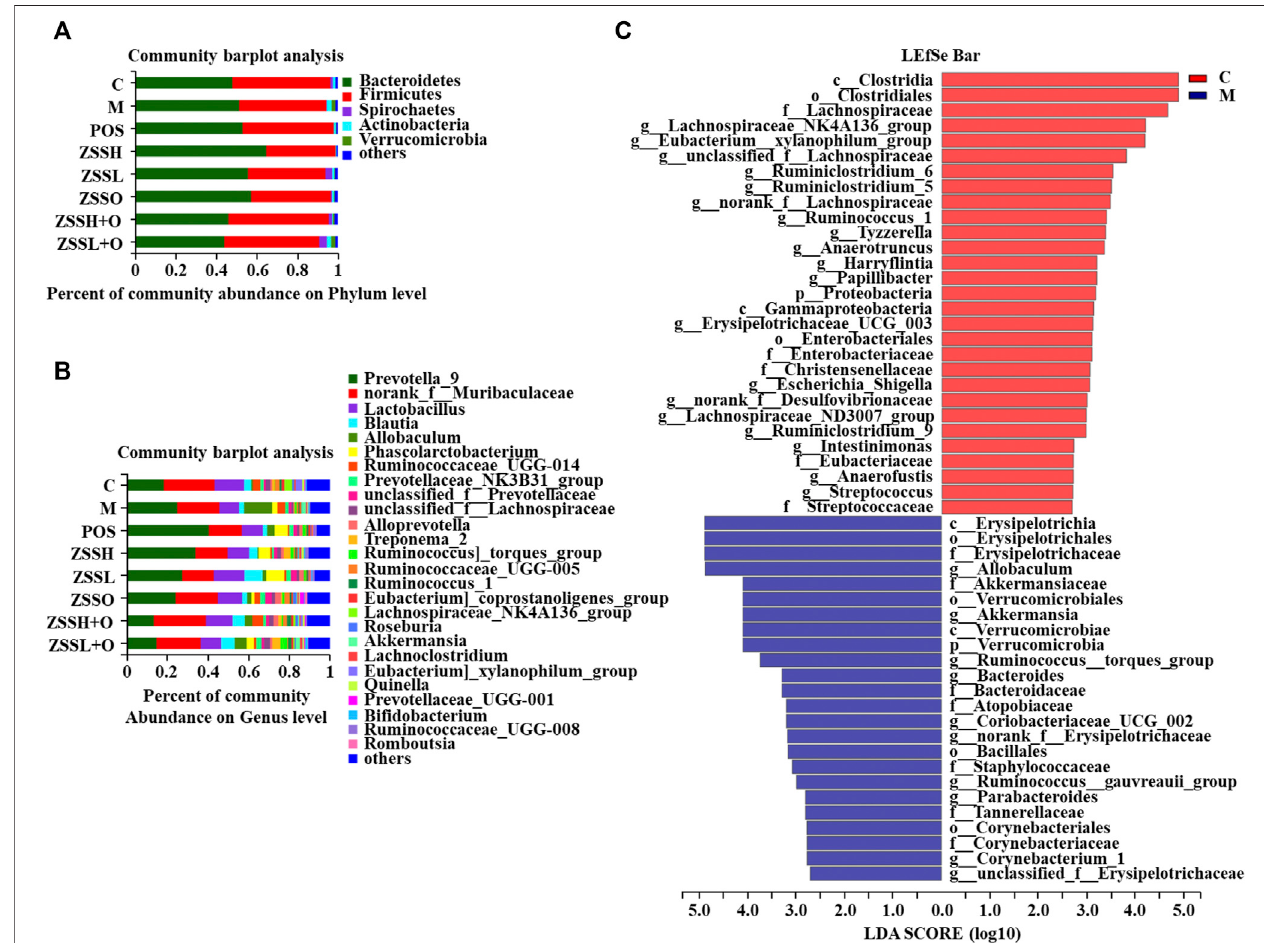
FIGURE 5 | Effects of ZSS extract on the structure and abundance of intestinal fl ora in insomnia rats. The percent of community abundance at the phylum (A) and genus (B) levels. LDA scores (C) were generated from LEfSe analysis, showing the differences in bacterial abundance at the genus level.